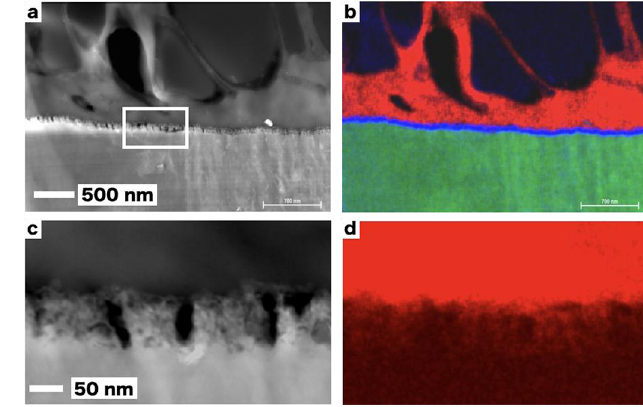
Fig. 16. (a) STEM-HAADF cross-sectional image and (b) STEM-EDX mixed map of S (red), O (blue), and Al (green) of the fracture surface of Al5052 after the fracture energy measurement. The surface treatment is NMT1. (c) Magni fi ed image of the region indicated in (a), and (d) is STEM-EDX S map of (c) representing PPS